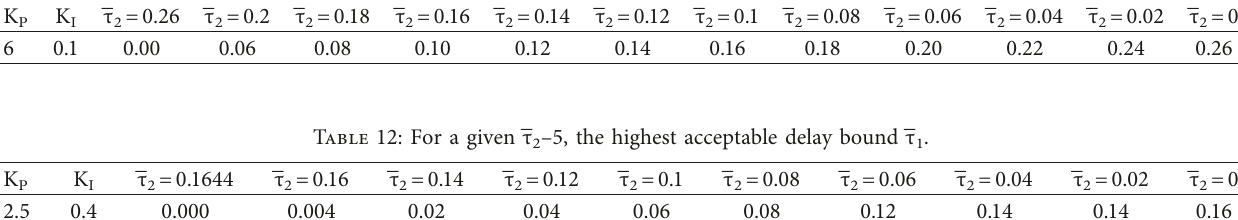
2– 4, the highest acceptable delay bound τ